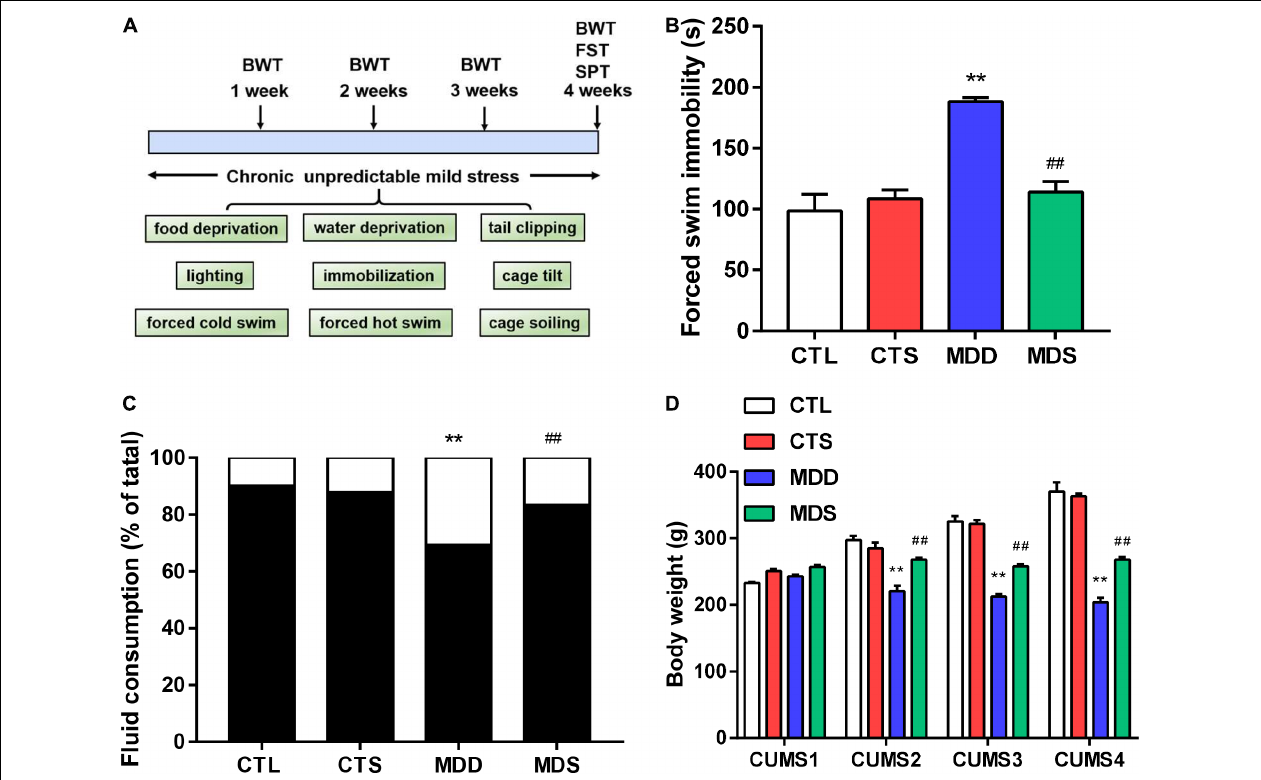
FIGURE 1 | Timeline and behavioral measurement results. (A) Timeline of procedures and stressors used in this study; (B) immobility time (higher in the MDD group after the procedure); (C) sucrose intake after 28 days of CUMS (significantly lower in the MDD group compared to the CTL group, but partially recovered in the MDS group); (D) body weight loss in the MDD group induced by CUMS in weeks 1, 2, 3, and 4; ∗∗ P < 0.01 vs. CTL group; ## P < 0.01 vs. MDD group. CUMS, chronic unpredictable mild stress; SPT, sucrose preference test, FST, forced swimming test, BWT, body weight